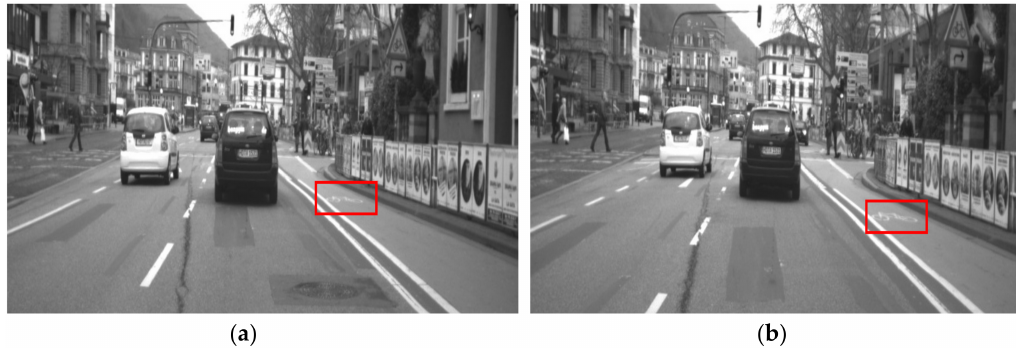
Figure 10. Faded bike markings on the road (red box). ( a ) Example 1 and ( b ) example